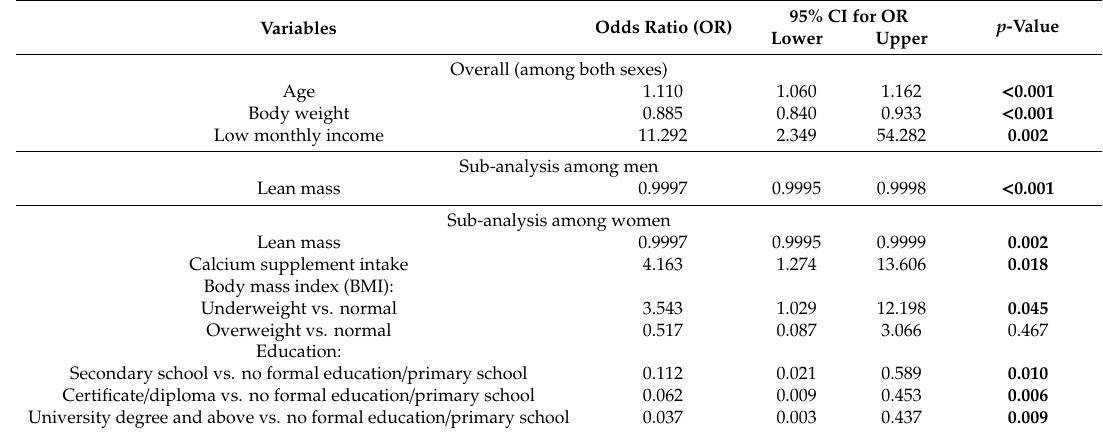
Table 4. Predictors of bone health status of the study population. The bolded p-values are statistically